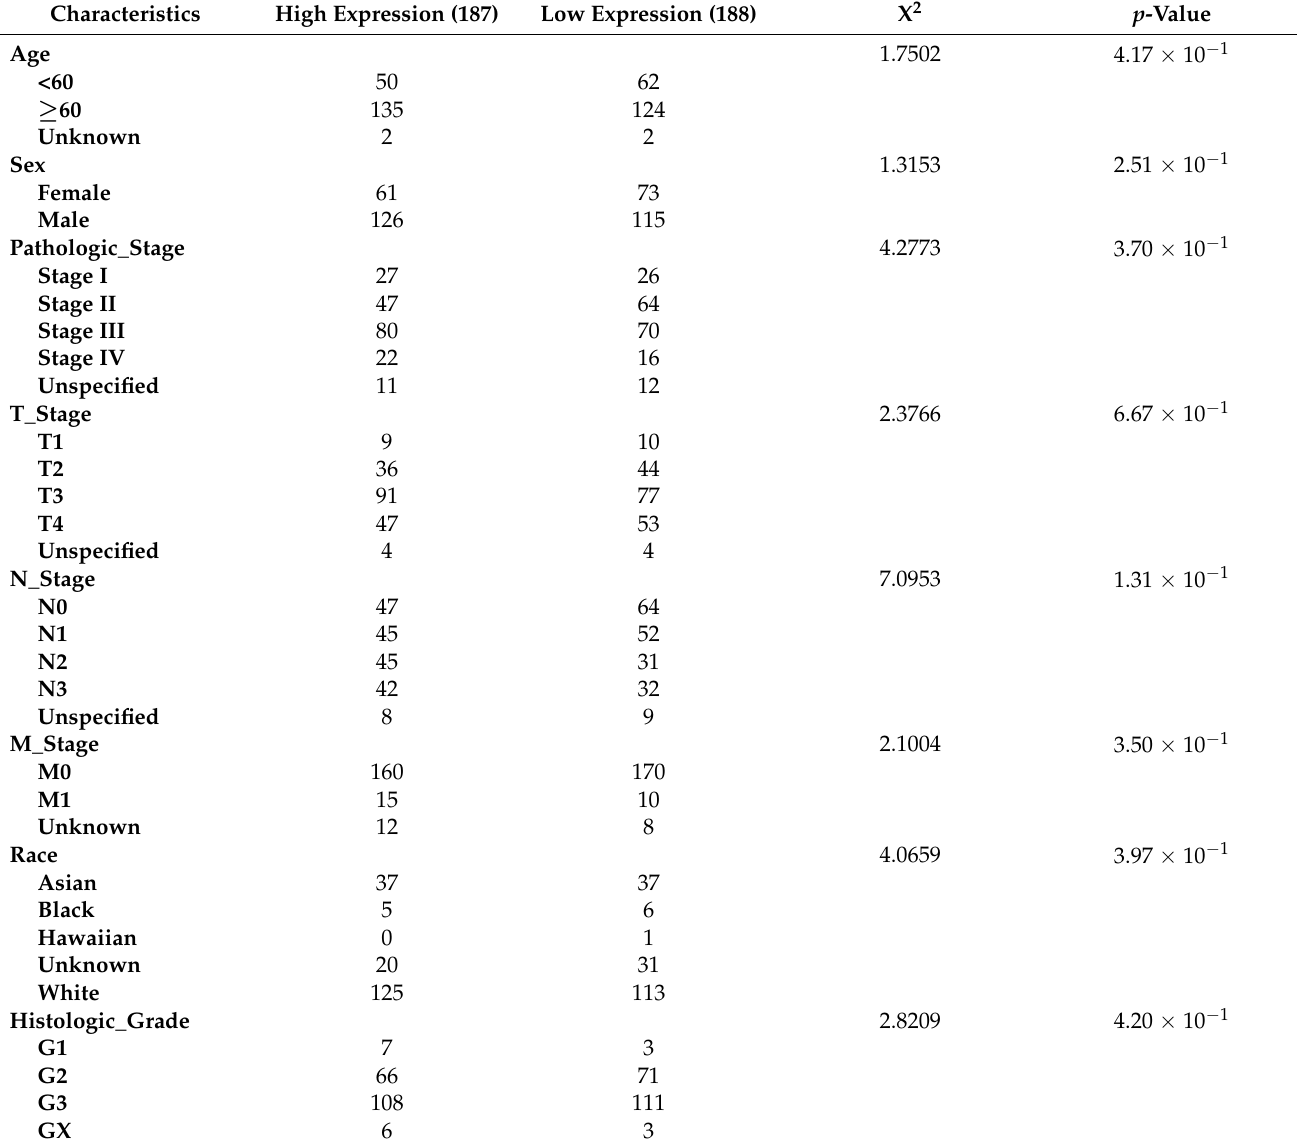
Table 3. Chi-squared-test analysis of clinical data and MAP4K4